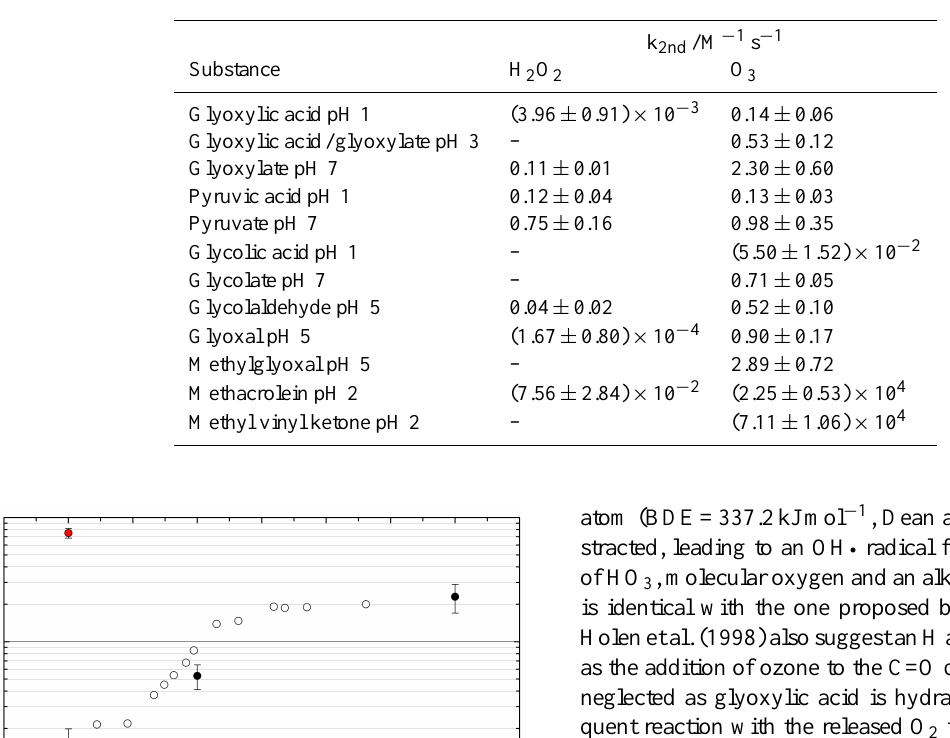
Table 2. Second-order rate constants [M − 1 s − 1 ] for the investigated systems. The uncertainties stated are statistical errors with the student t factor for the 95% confidence level derived from linear regression analysis.